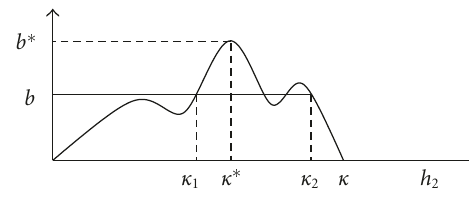
Figure 3.1 . Graph of ψ ( h ) (Theorem